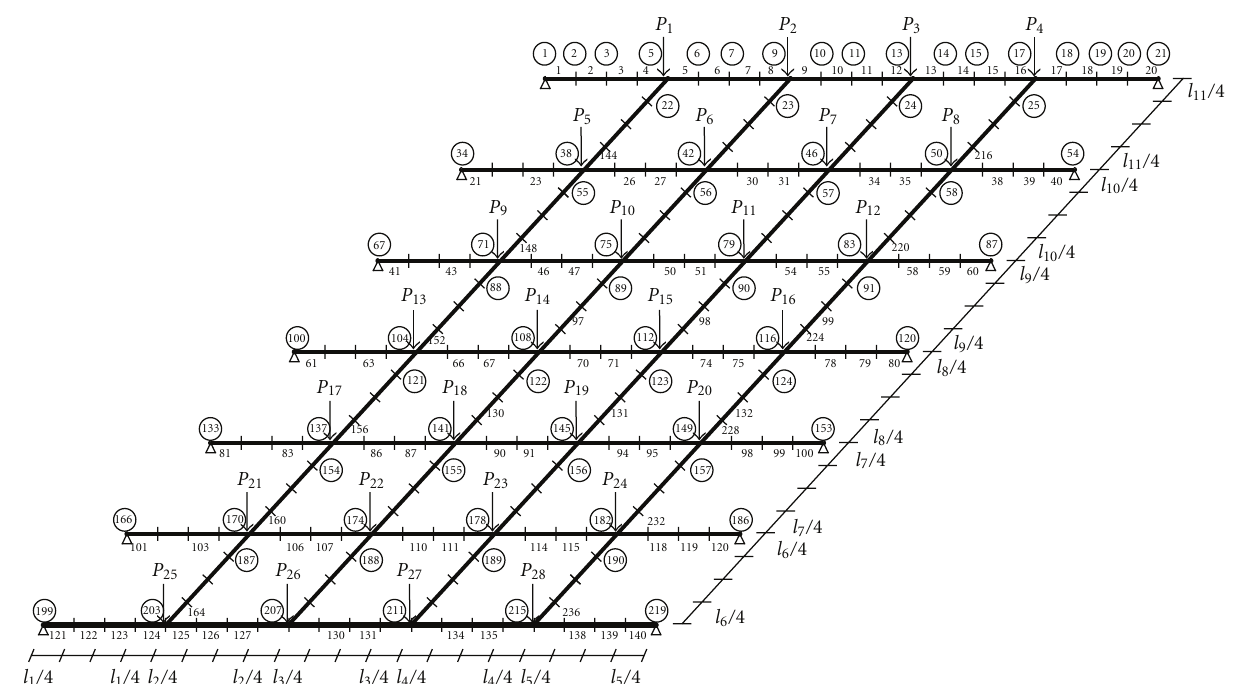
Figure 11: Geometry of 236-member grid structure including locations of point loads.